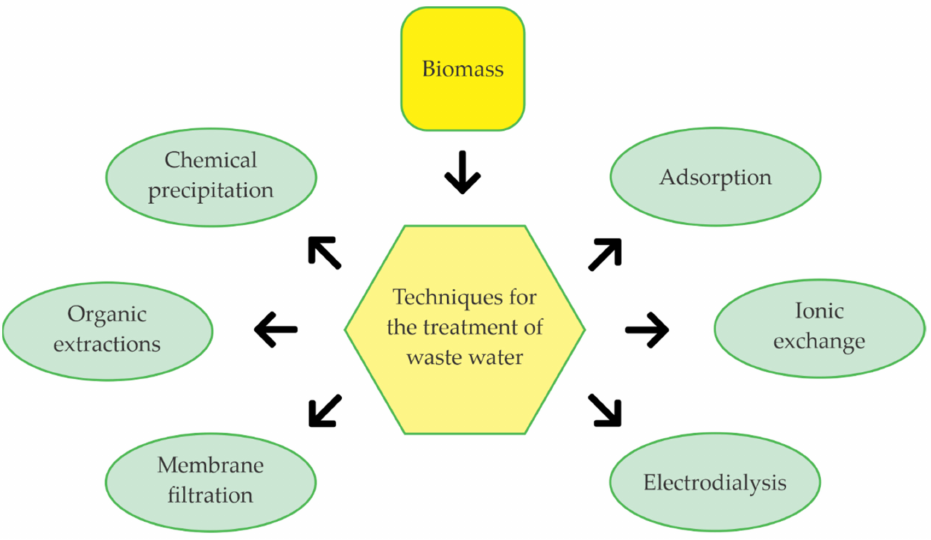
Figure 7. Techniques for the removal of heavy metals present in the water through banana biomass. Banana rachis has been used in adsorption and chemical precipitation methods